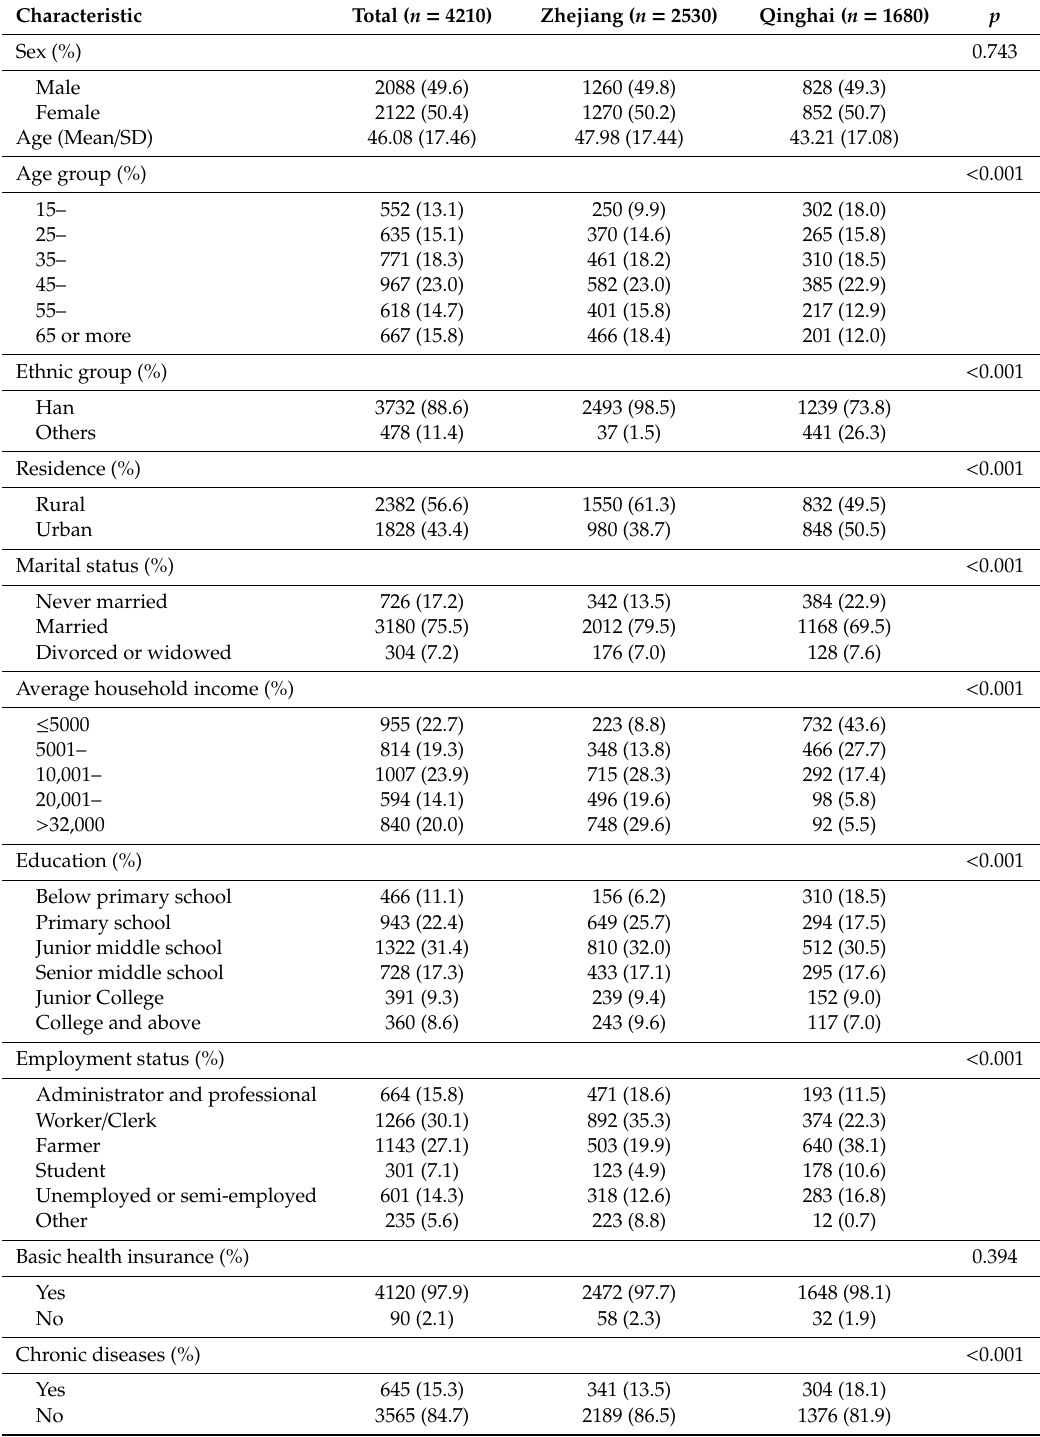
Table 2. Characteristics of the